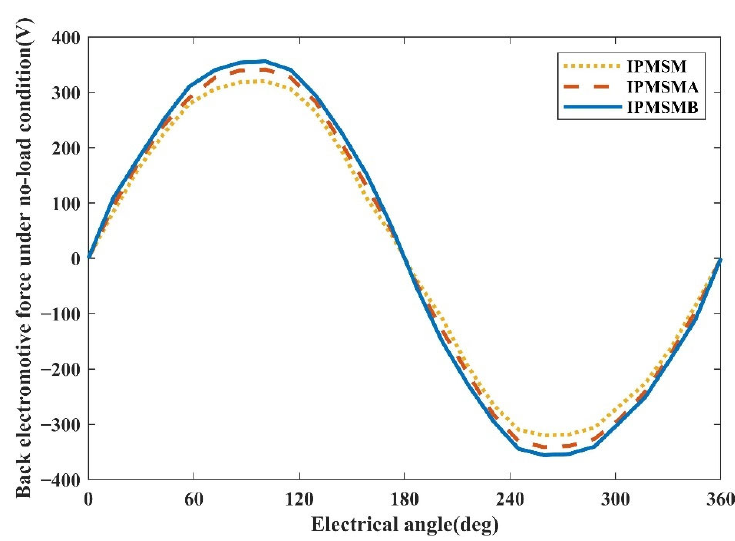
Figure 11. No ‐ load back EMF of three types of motors.